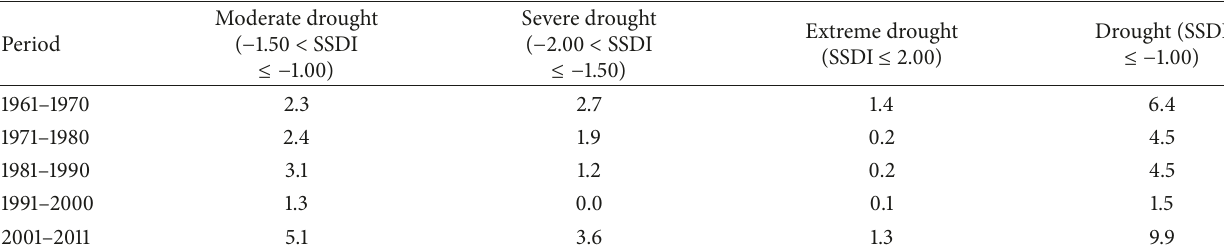
Table 5: The multiyear average area of drought in the MLJRB (unit 10 3 km 2